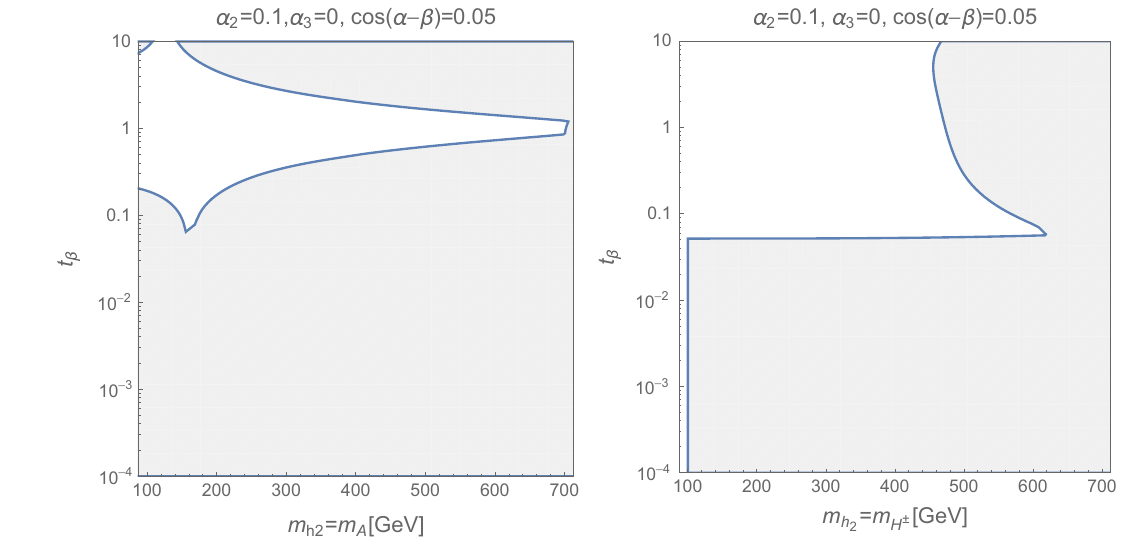
= m = 140 GeV in the right panel. The mixing and tan β . The gray regions and m h H ± and m A 2 2 = 1 TeV and between heavy CP -even scalars is taken to be zero 3 = m = 500 GeV in the left, A and m H ± 2